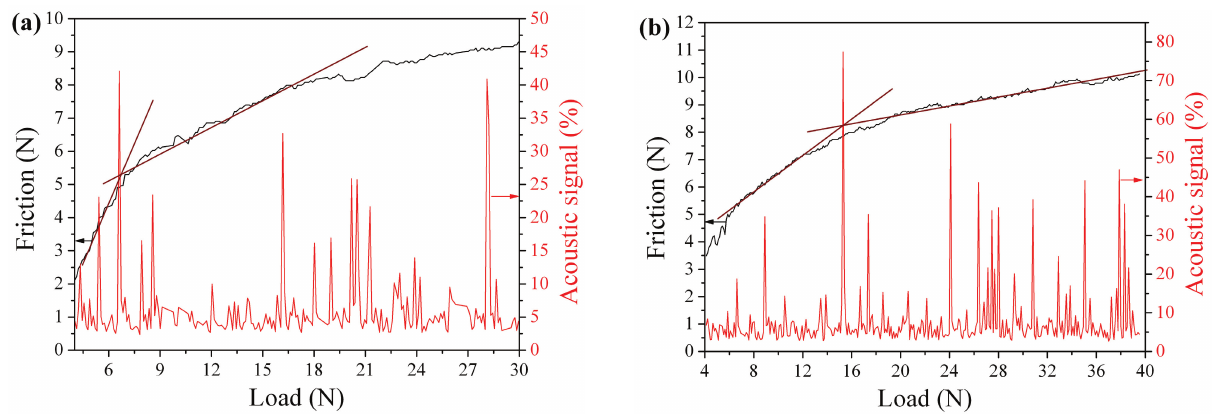
Figure 3. Scratch test curves of fiber-reinforced TBCs without (a) and with (b) micro-laminated ZrO 2 /Al 2 O 3 interlayers. stripped.